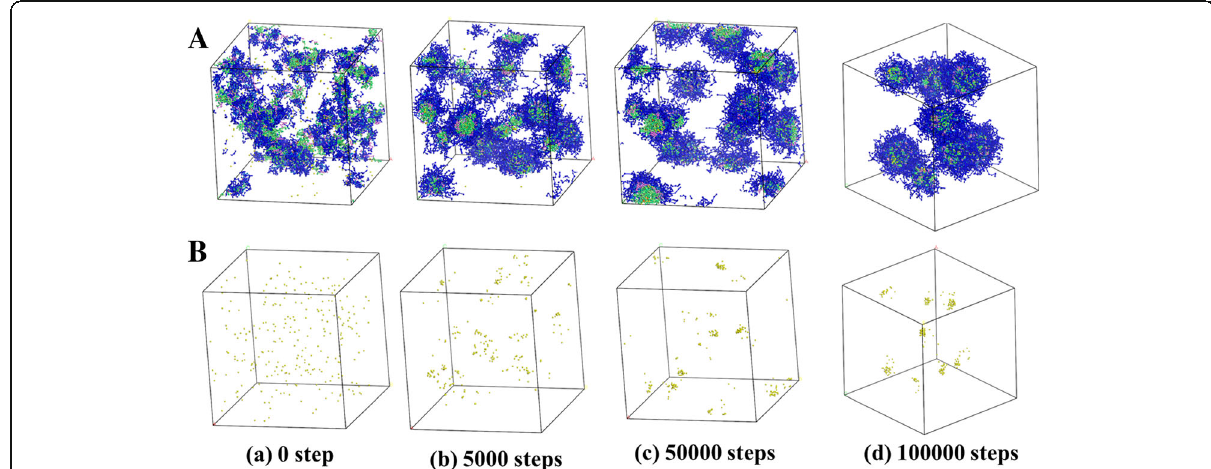
Fig. 1 DPD simulation of the growth process and distribution of AgNPs with PDMAEMA- b -PHEMA- b -PPEGMA at PDMAEMA/AgNO 3 molar ratio = 1/1 in different simulation time. a The water molecules were hidden for clarity. b Only the AgNPs were